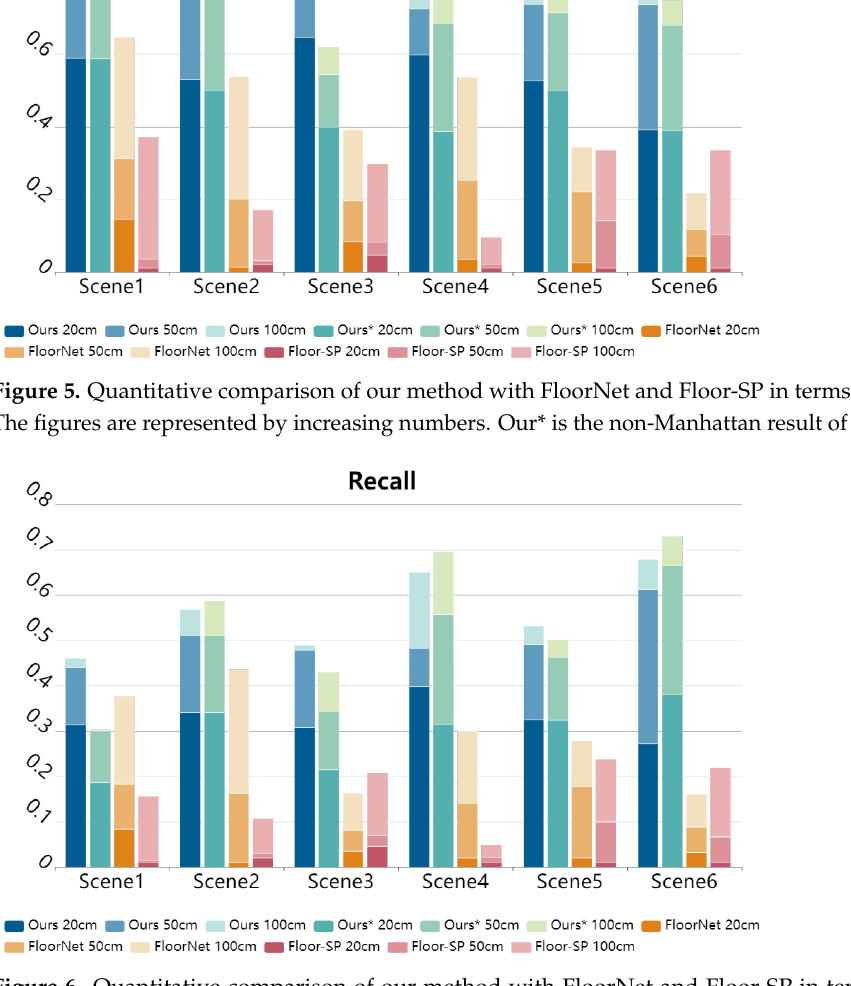
Figure 6. Quantitative comparison of our method with FloorNet and Floor-SP in terms of recall. The figures are represented by increasing numbers. The figures are represented by increasing numbers. Our* is the non-Manhattan result of our